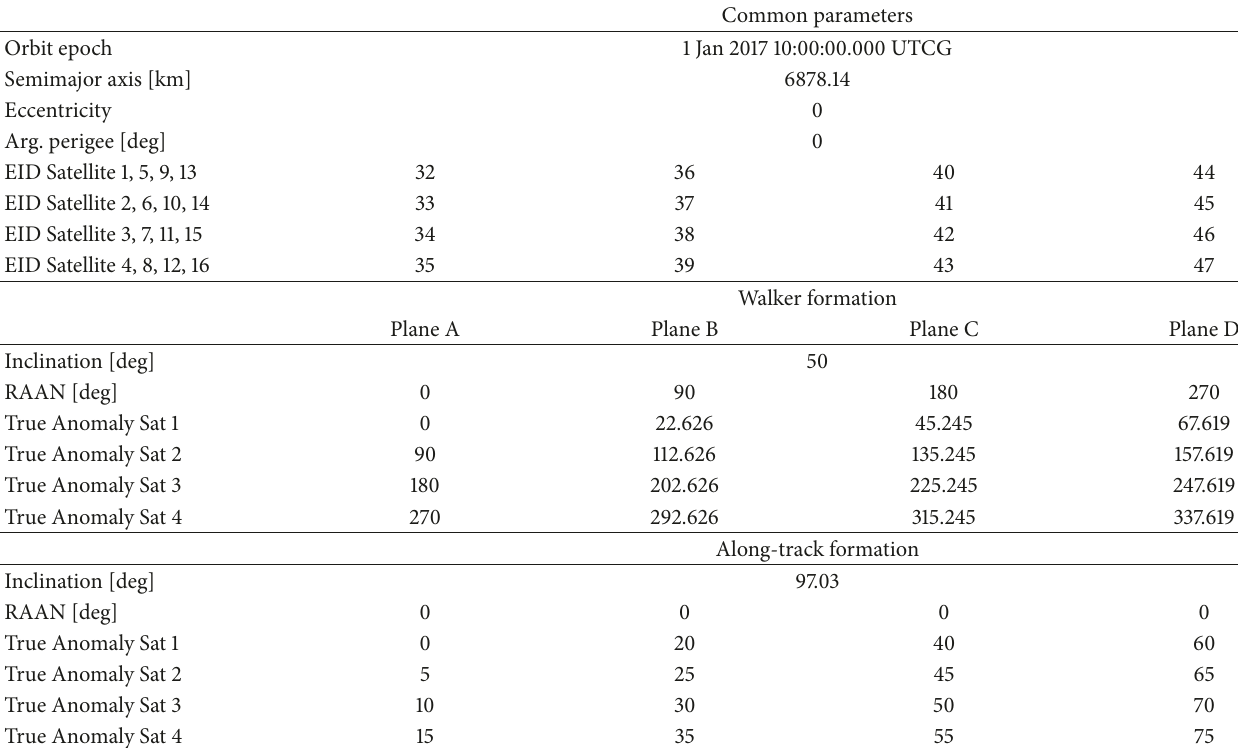
Table 3: Satellite